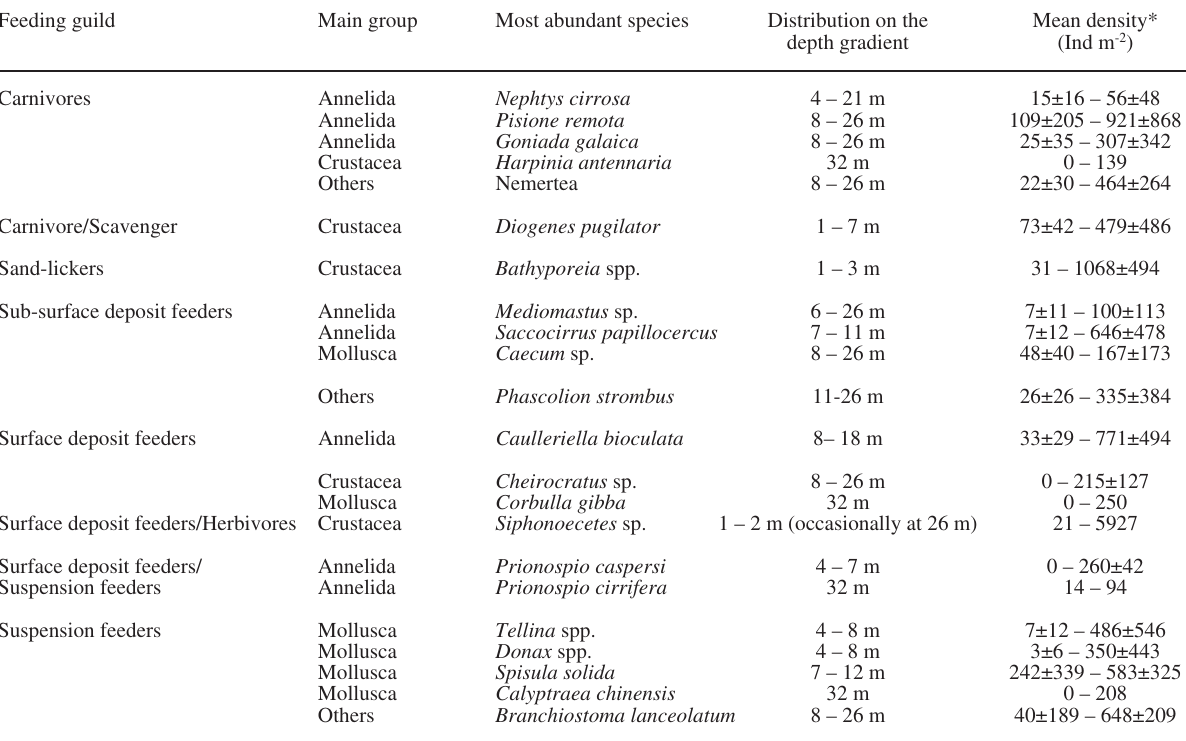
Table 2 . – the most abundant species in the macrobenthic community per feeding guild. the depth distribution and *minimum and maximum mean density (± standard deviation) are indicated for the considered depth distribution. Feeding